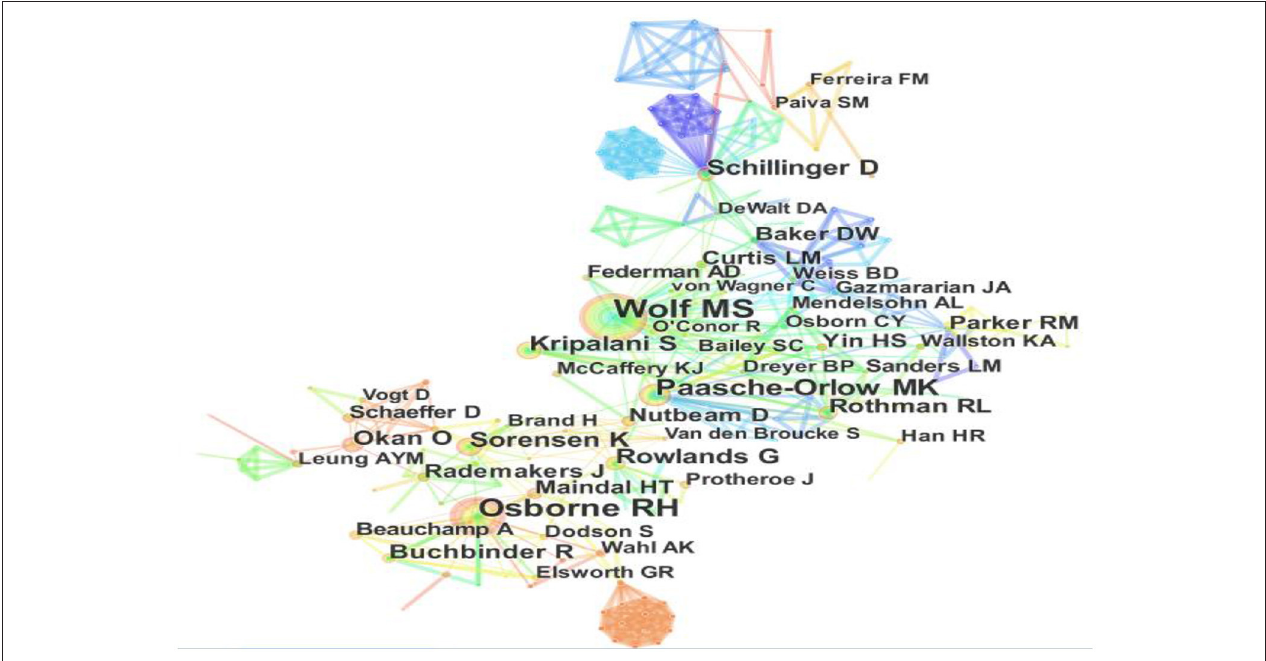
FIGURE 5 | Visualization on main research contributors in health literacy.